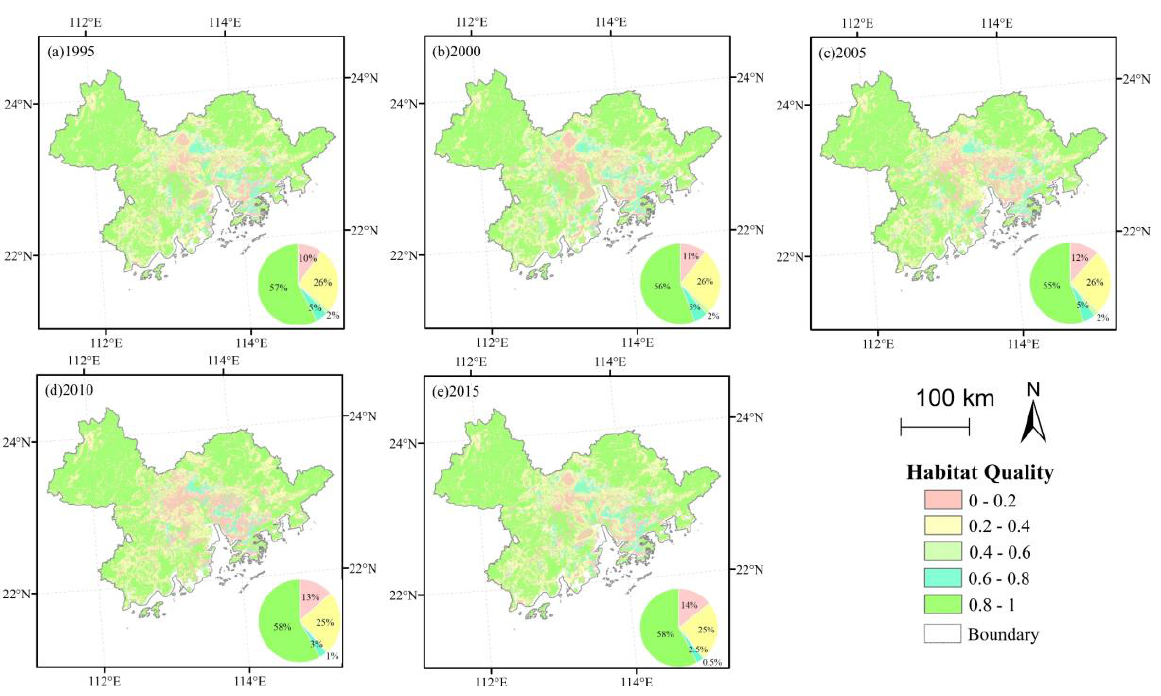
Figure 6. Spatial distribution of habitat quality in the GBA during the period from 1995 to 2015: ( a ) 1995; ( b ) 2000; ( c ) 2005; ( d ) 2010; ( e ) 2015; the inset pie chart shows the proportions of each habitat quality range for different years.